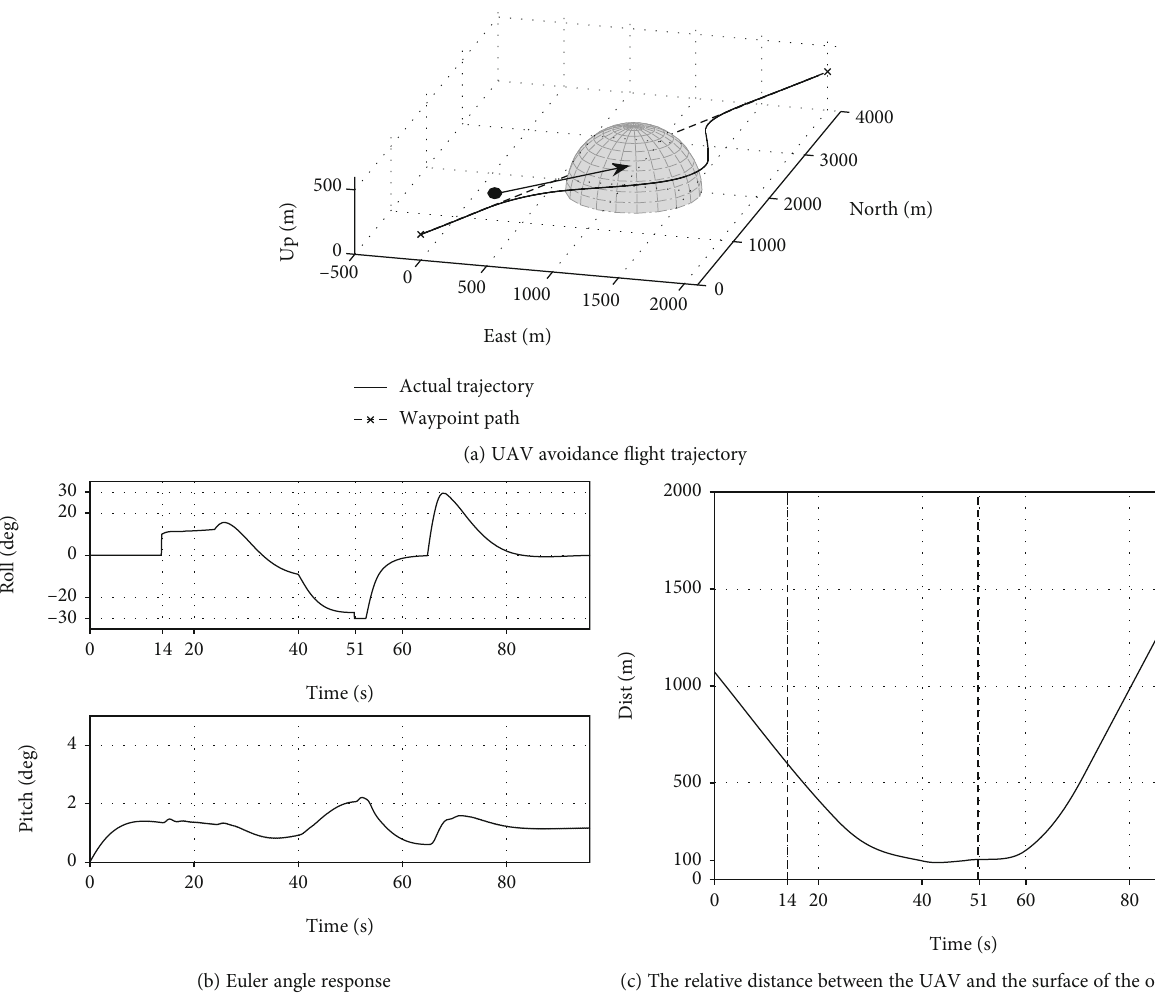
(c) The relative distance between the UAV and the surface of the obstacle Figure 12: UAV fl ight status of the dynamic obstacle avoidance